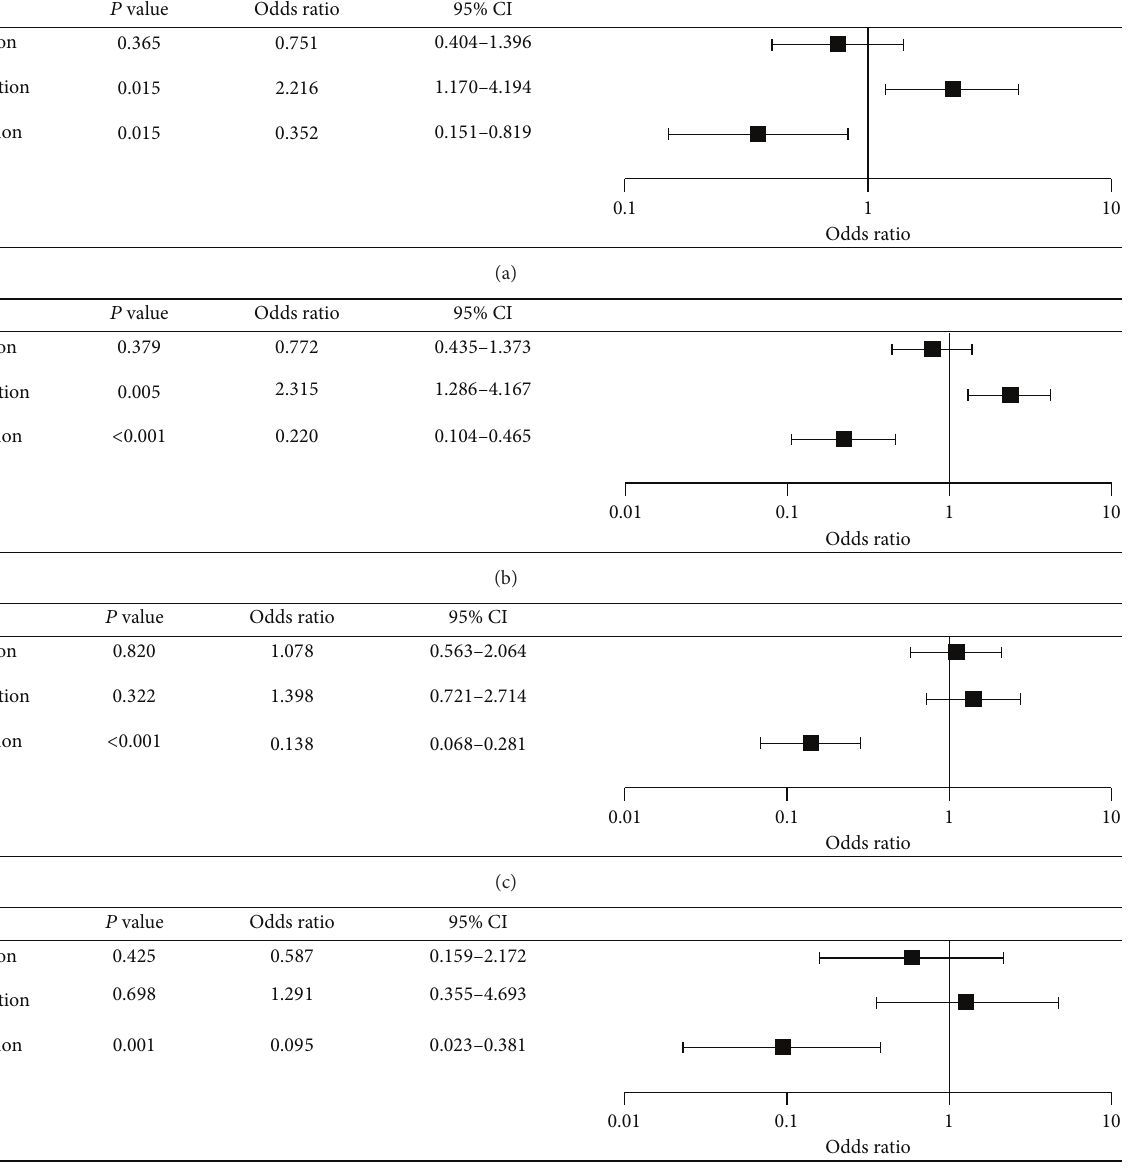
Figure 3: Logistic regression analysis of the epidural spread at (a) L2-3, (b) L3-4, (c) L4-5, and (d) L5-S1 disc levels after injection of 14mL of